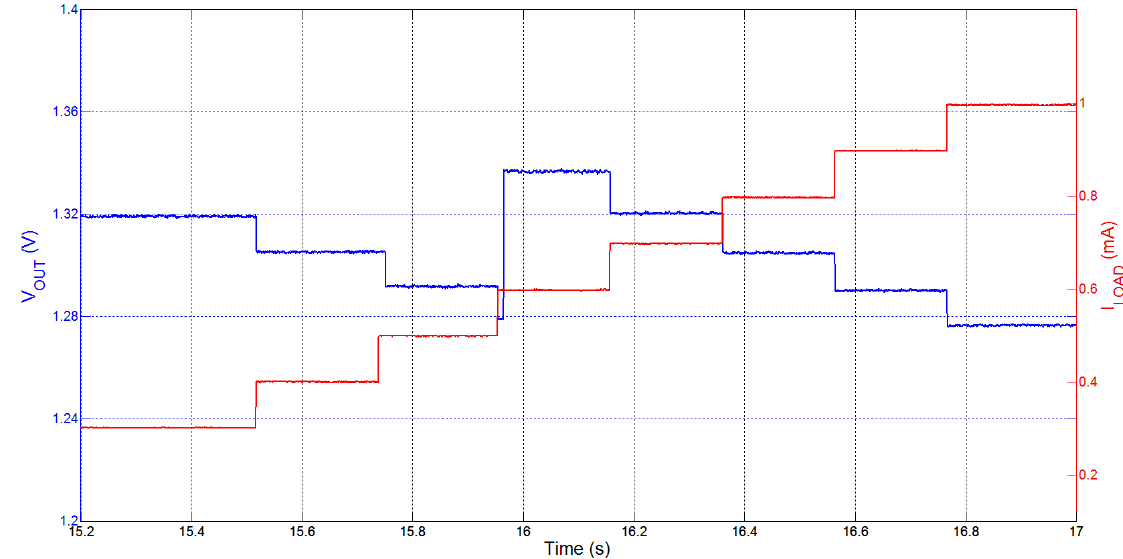
Figure 5. Measured V regulation at 1.30 V as the load current steps from 300 µ A to OUT 1 mA in steps of 100 µ A.